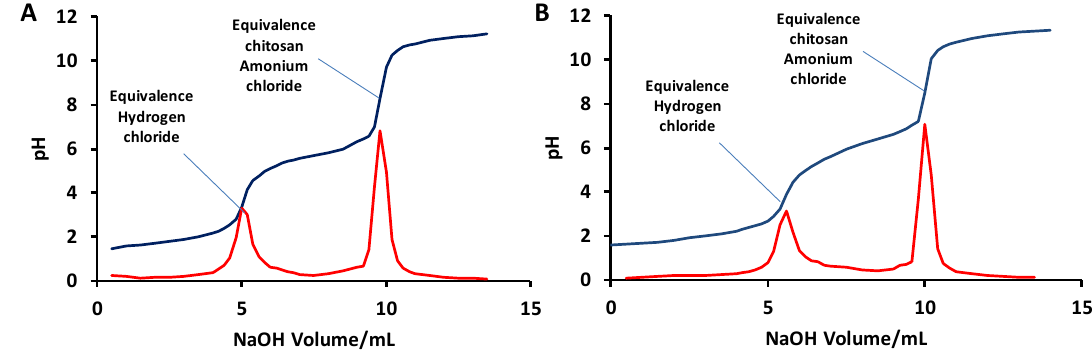
Figure 10. Example of titration curve for G. orientalis ( A ) and shrimp ( B ) chitosan deacetylation degree determination. 245